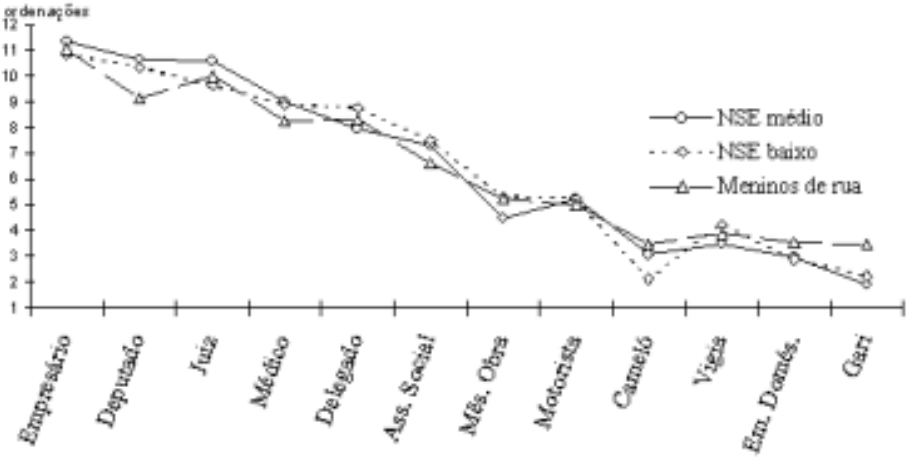
Figura 5 . Interação NSE x Ocupação. VD: Ordenação das ocupações em função da